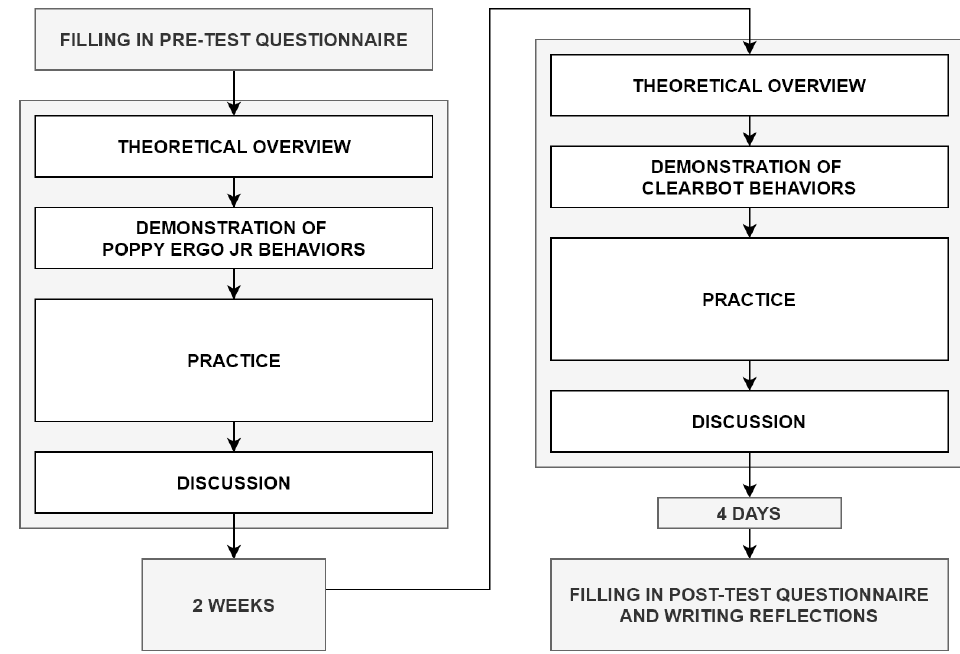
Figure 4. The structure of the “ My Future Colleague Robot ” workshop [53].